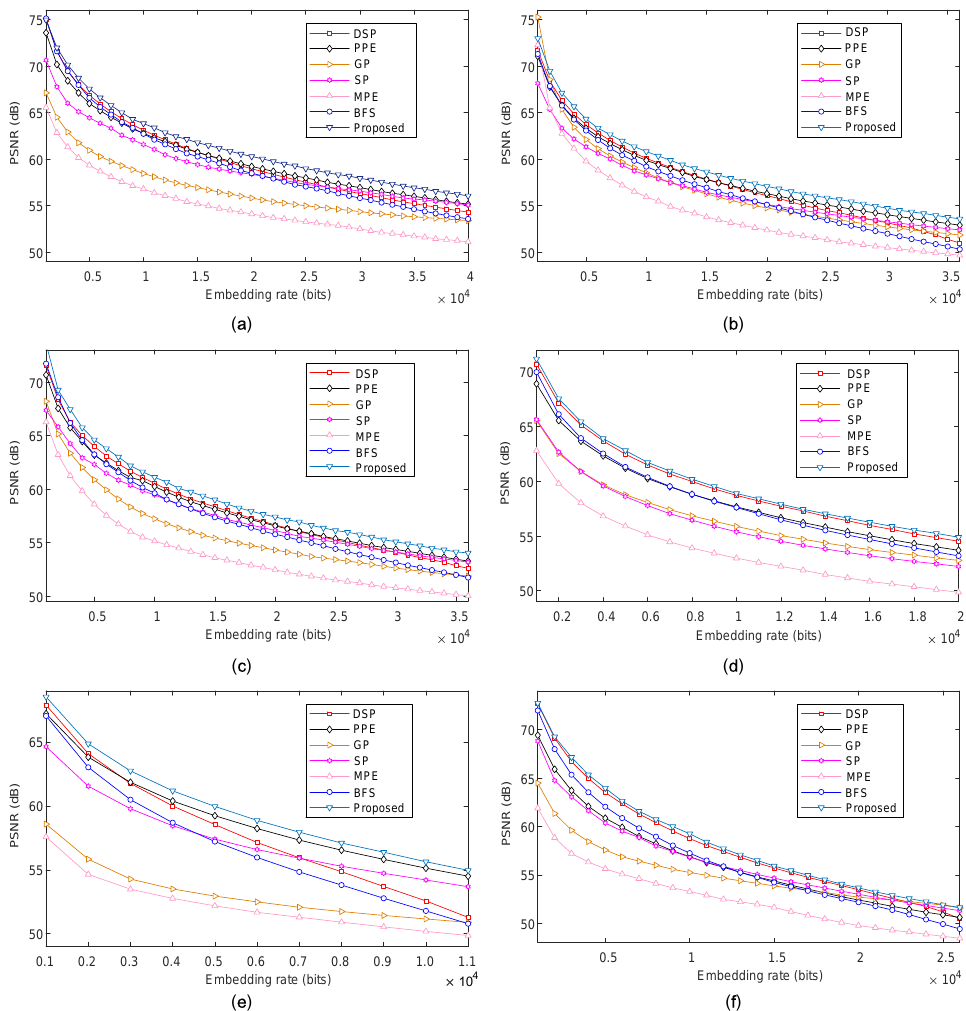
Figure 9. Performance comparison between the proposed method and the methods introduced by DSP [14], PPE [14], GP [29], SP [13], MPE [15] and BFS [28]: ( a ) Airplane , ( b ) Lena , ( c ) Tiffany , ( d ) Peppers , ( e ) Baboon , ( f ) Sailboat